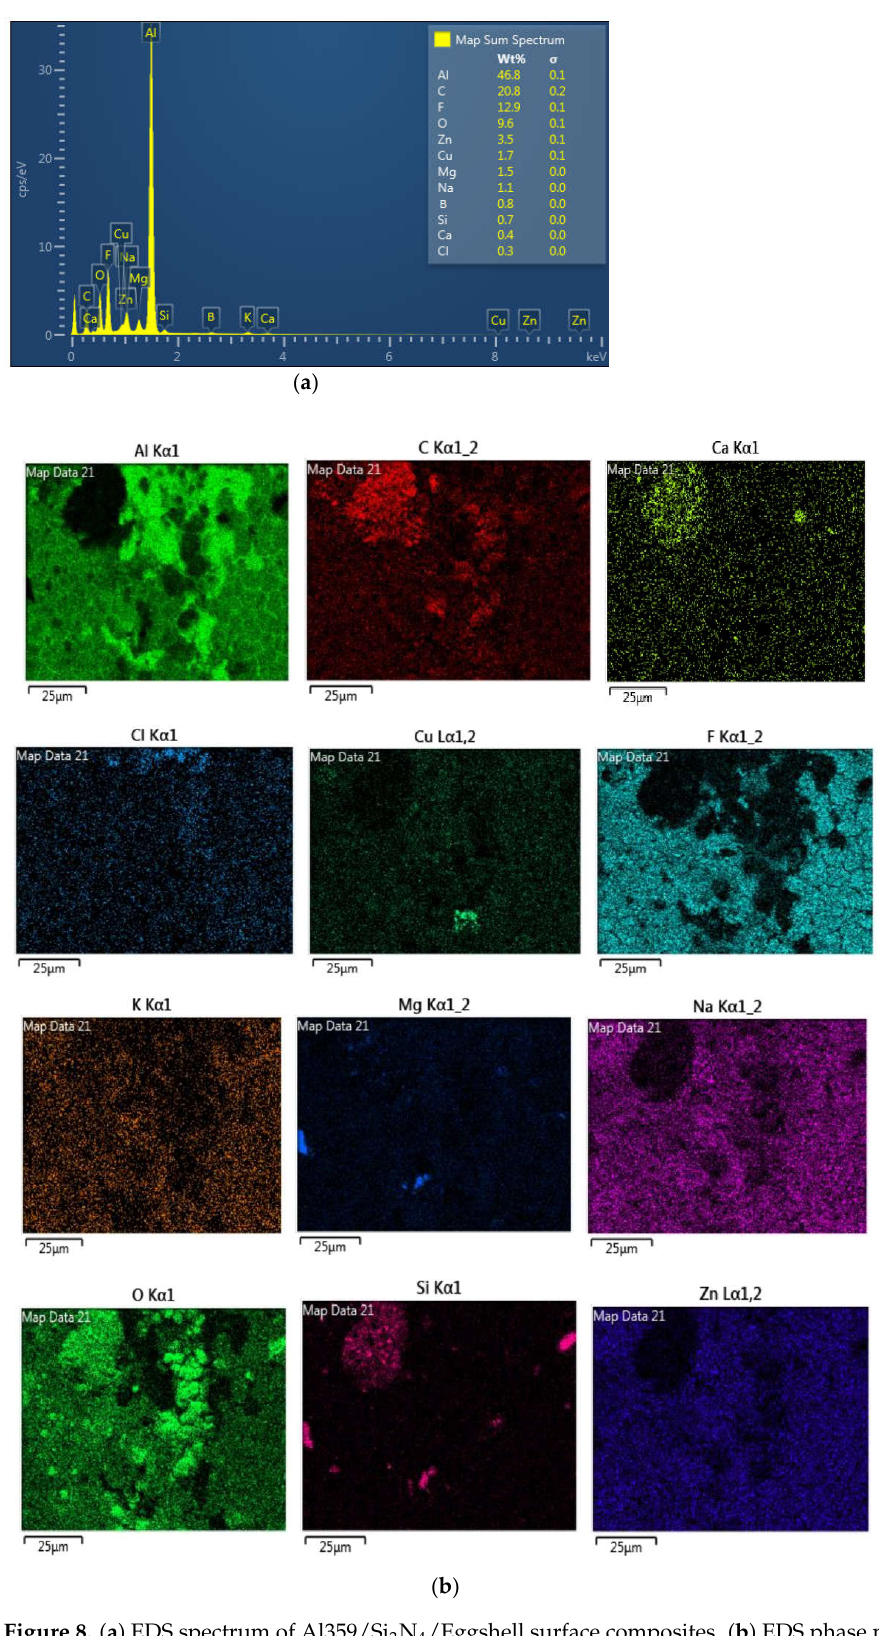
Figure 8. ( a ) EDS spectrum of Al359/Si 3 N 4 /Eggshell surface composites. ( b ) EDS phase mapping of Al359/Si 3 N 4 /Eggshell surface